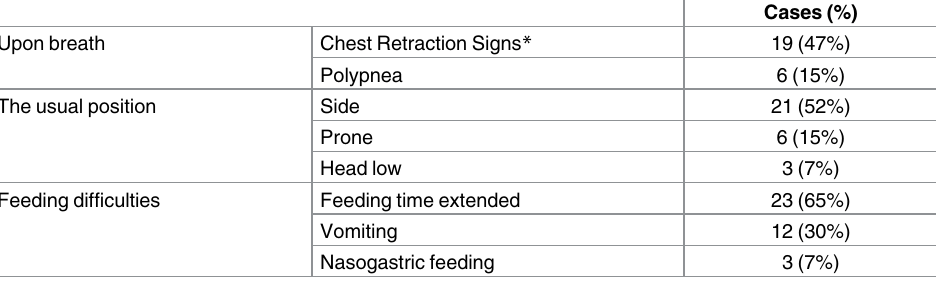
Table 1. Patient distribution on breath and feeding difficulties (preoperative).